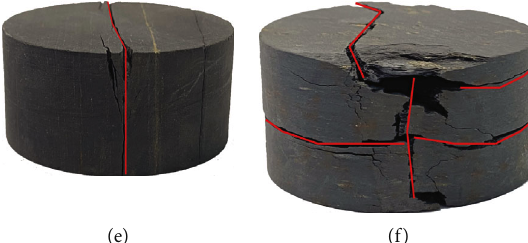
Figure 17: The stress-displacement curve of dry and saturated shales: (a) parallel bedding shales without LN preconditioning; (c) vertical bedding shales without LN bedding shales after LN 2 preconditioning. The failure pattern of shale in the Brazilian disc test: (e) parallel bedding shale; (f) vertical bedding